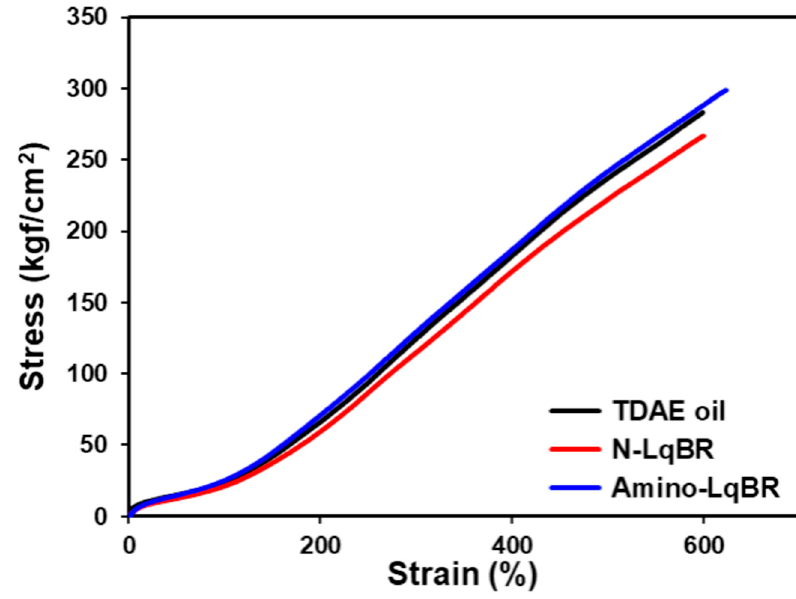
Figure 9. Stress–strain curves of vulcanizates. Table 8. Mechanical properties and abrasion resistance of vulcanizates.